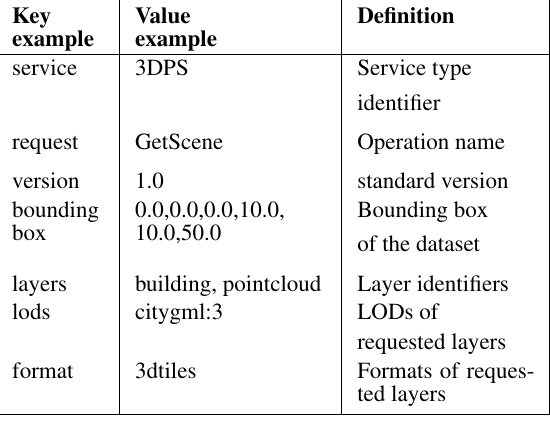
Table 1. Example of 3DPS HTTP/GET KVP-based encoding